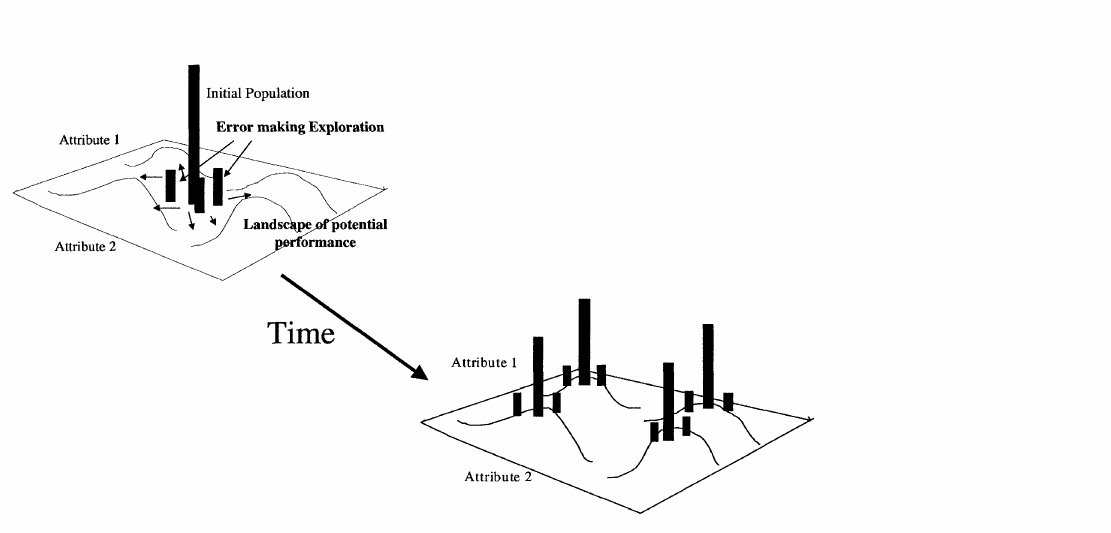
FIGURE 3 The effects of behavioural exploration in possibility space are structural